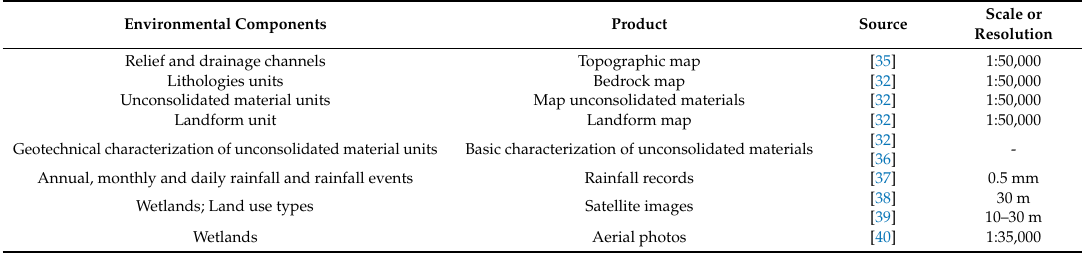
Table 1. Collected data on environmental components and the corresponding product, source, and spatial scale.